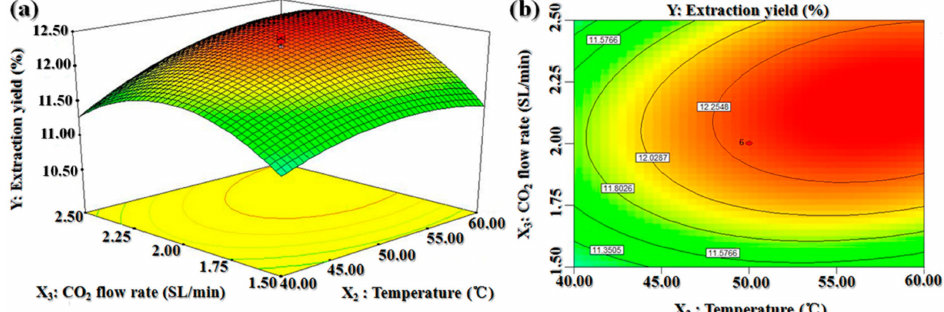
Figure 4. Response surface ( a ) and contour plots ( b ) for the e ff ect of temperature and CO 2 flow rate on the B. dasystachya seed oil yield.